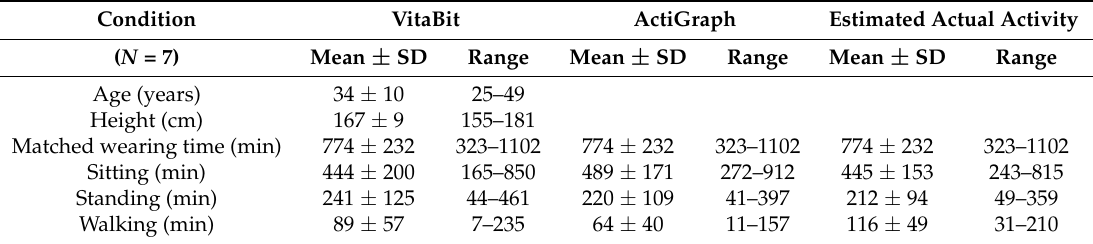
Table 6. Free Living: Description of population and activity distributions.